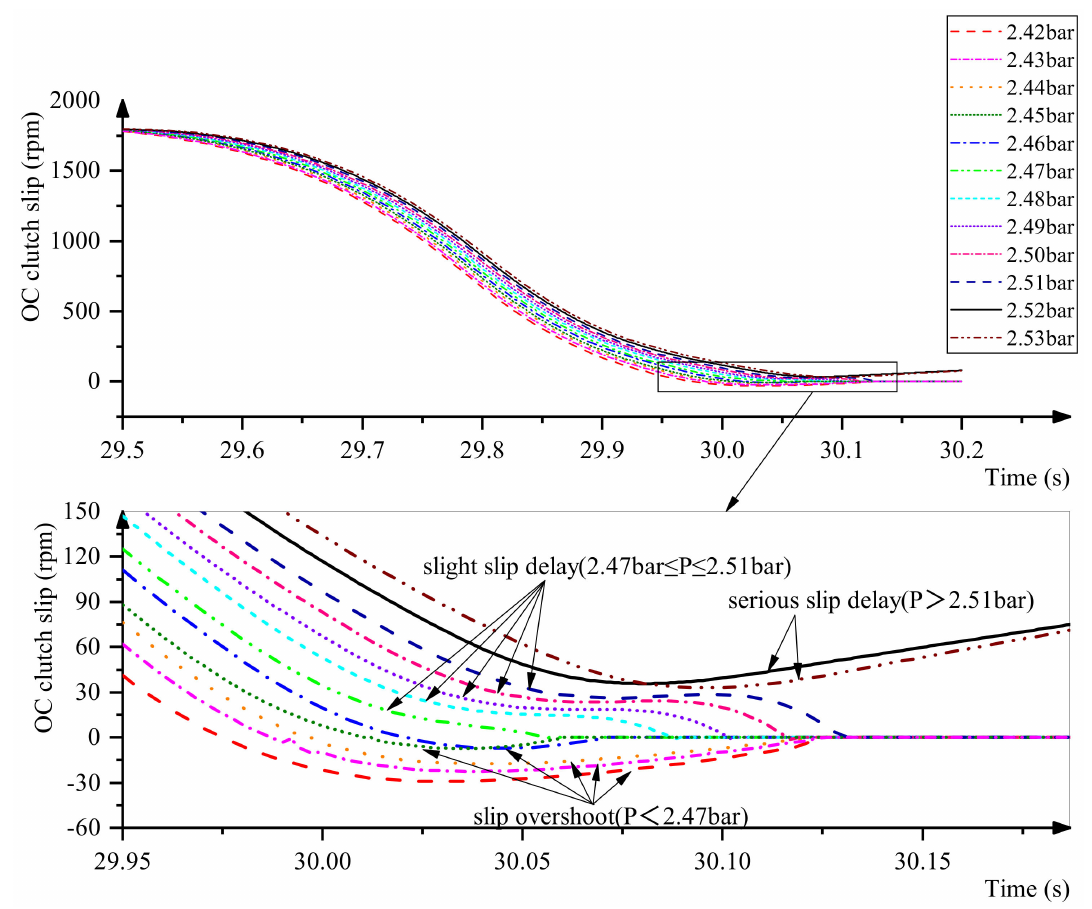
Figure 11. Variations of the OC clutch slip under different P 2